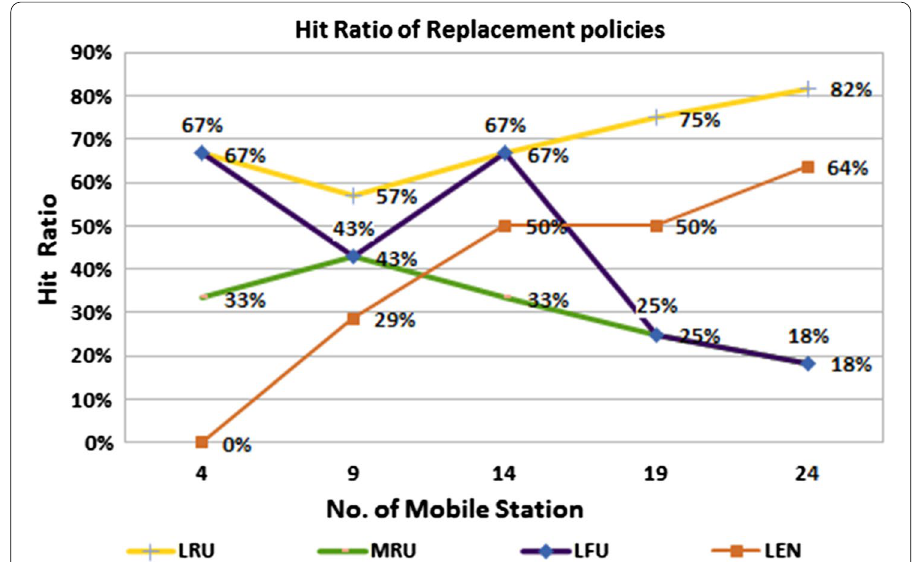
Fig. 6 The Hit ratio of SBS Cache comparison between LRU, MRU, LRU and LEN for different number of MSs